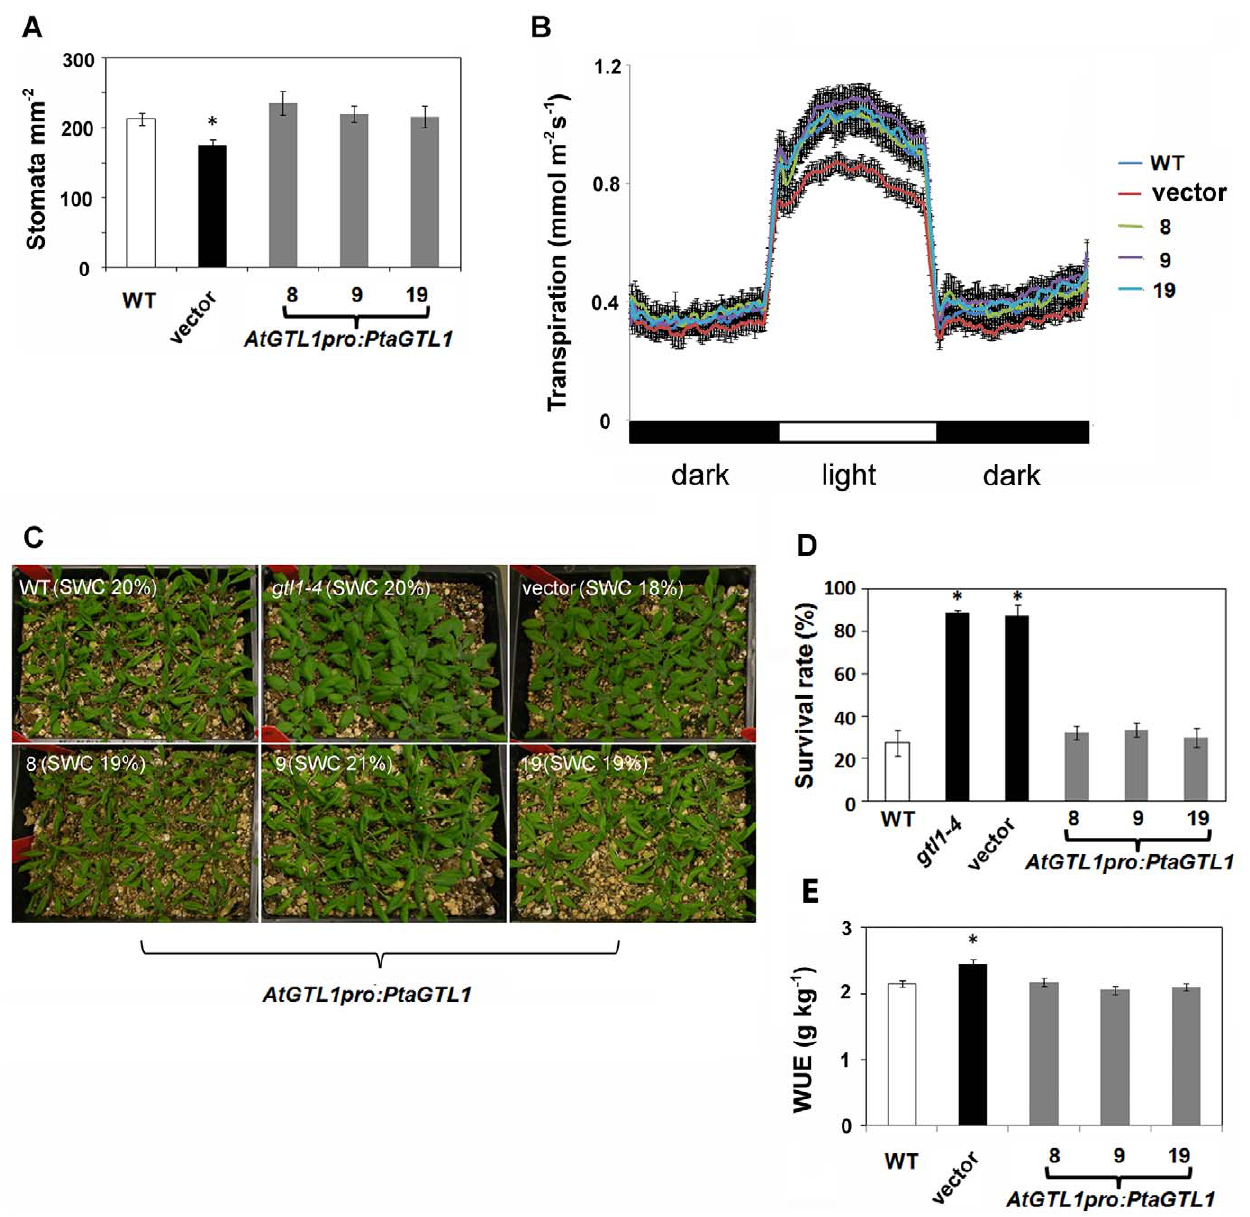
Figure 3. AtGTL1pro:PtaGTL1 expression suppresses the stomatal density, drought tolerance, and WUE phenotypes of gtl1-4 . A. Stomatal density (number of stomata per mm 2 ) of leaf abaxial epidermis (fully expanded rosette leaves) from 45-day-old plants (12/12 hr photoperiod) was determined (mean 6 SE, n=3). Asterisk indicates that the mean value of vector plants is significantly different from that of wild type at P , 0.05 (Student’s t-test). B. Diurnal transpiration rates of 5-week-old plants grown in a growth chamber (12/12 hr photoperiod) were determined gravimetrically (mean 6 SE, n=4). C. Plant water-deficit tolerance of 3-week-old plants (16/8 hr photoperiod) was evaluated in four 15 cm 6 20 cm containers per genotype (20 plants per container). Representative containers for each genotype were photographed 12 days after withholding water and relative soil water content (SWC) is indicated in brackets. SWC equals water content 12 days after withholding water/water content at saturation. D. Survival rate was determined after 14 days without watering and 4 days after re-watering (mean 6 SE, n=4 containers, 20 plants per container). After 14 days without water, all genotypes had the same relative SWC, WT, 15.3 6 2.2 g; gtl1-4 , 15.3 6 2.0 g; vector, 14.0 6 1.8 g; # 8, 15.4 6 2.8 g; # 9, 16.4 6 1.2 g, and 14.3 6 1.5, mean 6 SEM. E. Integrated WUE B under water-sufficient conditions was determined over a period of 3 weeks, starting with 17-day-old plants. Water loss throughout the growth period was determined by weighing containers before and after each irrigation. Total water loss is the sum of three determinations (WT, 62.9 6 2.8 g; vector, 54.3 6 3.0 g; # 8, 60.7 6 4.0 g; # 9, 61.6 6 2.7 g; and # 19, 64.2 6 3.3 g, mean 6 SEM). Shoot dry weight was determined at the completion of the experiment (WT, 126 6 7 mg; vector control, 122 6 6 mg; # 8, 124 6 10 mg; # 9, 117 6 5 mg; and # 19, 125 6 6 mg, mean 6 SEM). WUE B was calculated as shoot dry weight divided by total water loss (mean 6 SE, n=12 to 15). Asterisk indicates that WUE B of vector plants is significantly different from that of wild-type plants at P , 0.05 (Student’s t-test). All 3 lines of gtl1-4 expressing PtaGTL1 have the same WUE B as wild-type plants.